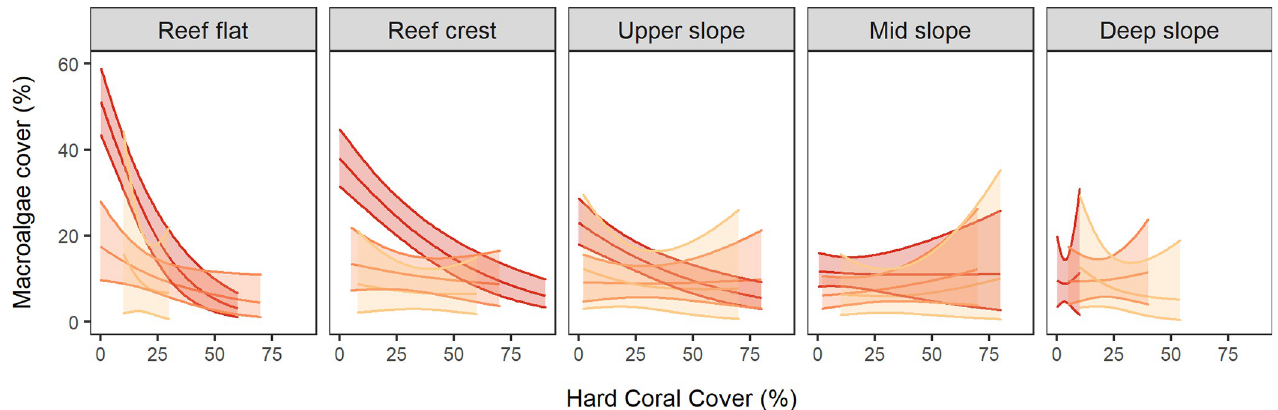
Fig 5. Relationship between macroalgal cover (where MA was present), and hard coral cover. Plots based on the one-off surveys across five depth zones and three shelf positions (Red = Inshore, Orange = Mid-shelf, Light orange = Outer shelf). Solid lines are modelled higher posterior distribution means, shadings are 95% Bayesian Credible Intervals. Statistical differences can be inferred where 95% CIs do not